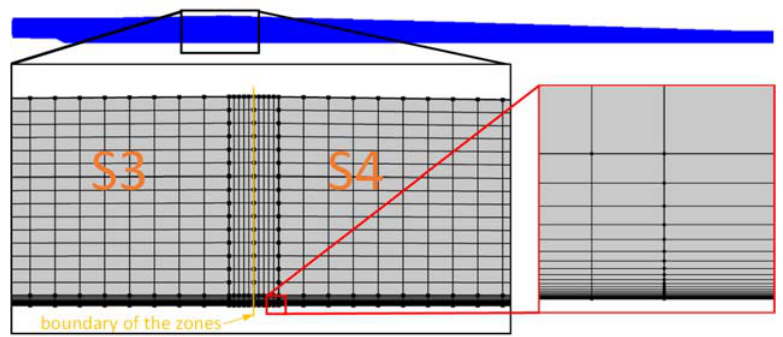
Figure 6. Meshed cell with quad elements of a barrel (shown in Figure 1).